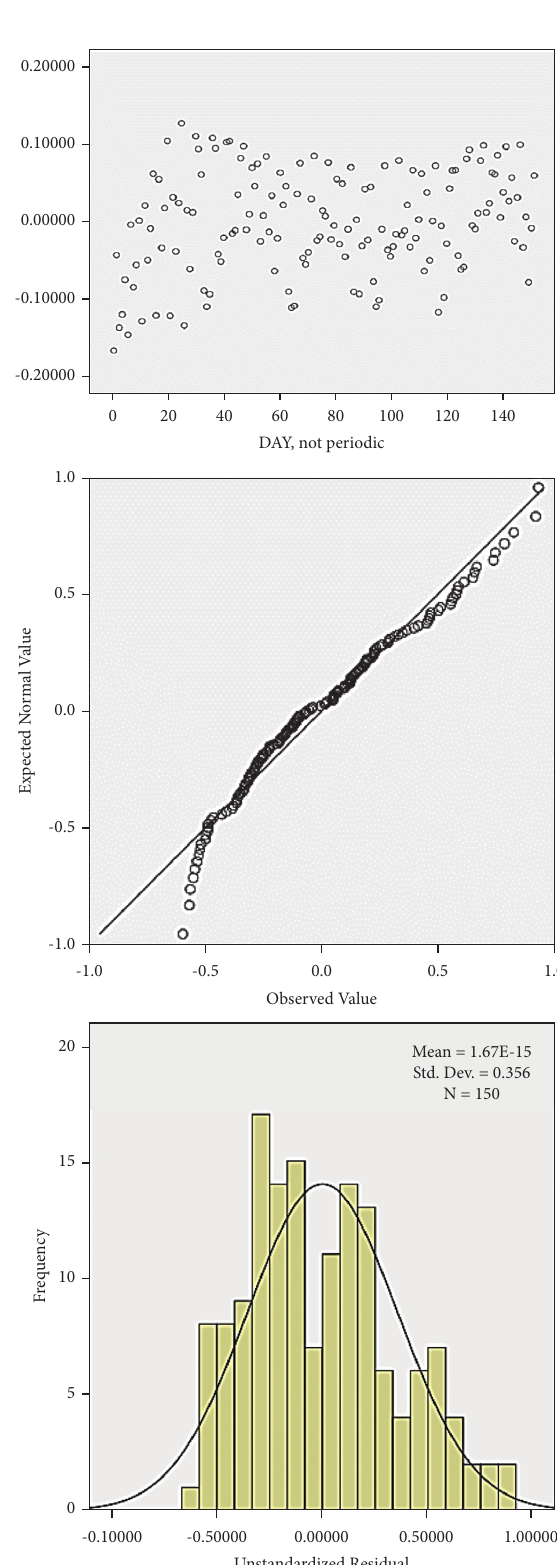
Figure 20: Histogram, quadratic diagram, and variance diagram of reverse angle